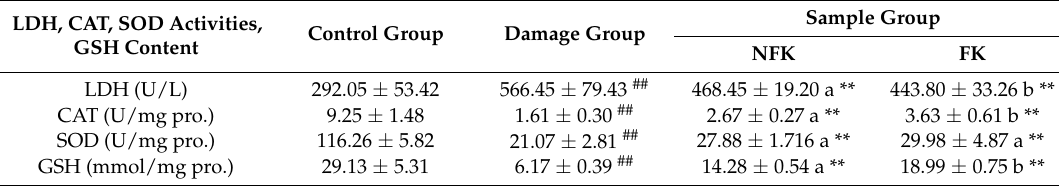
Table 2. Effect of NFK and FK on LDH contents, CAT and SOD activities, and GSH contents in PC12